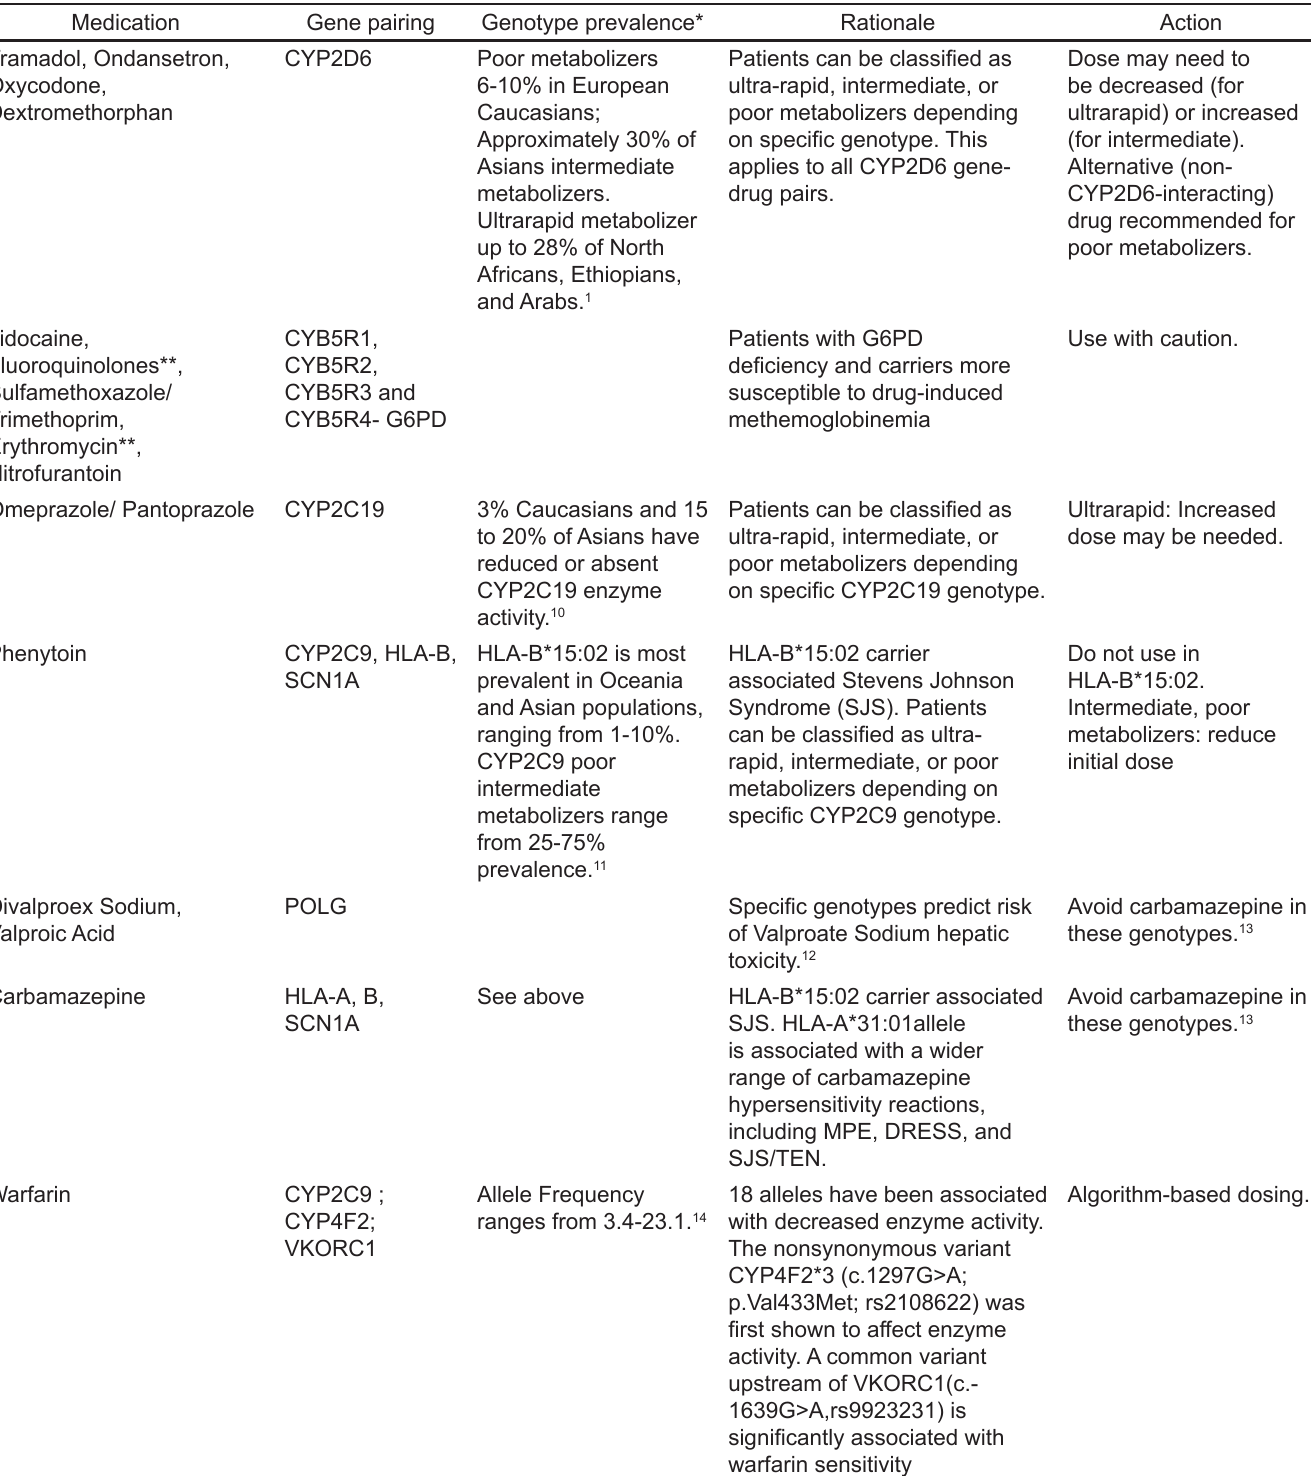
Table 3. Actionable pharmacogenetic guidance